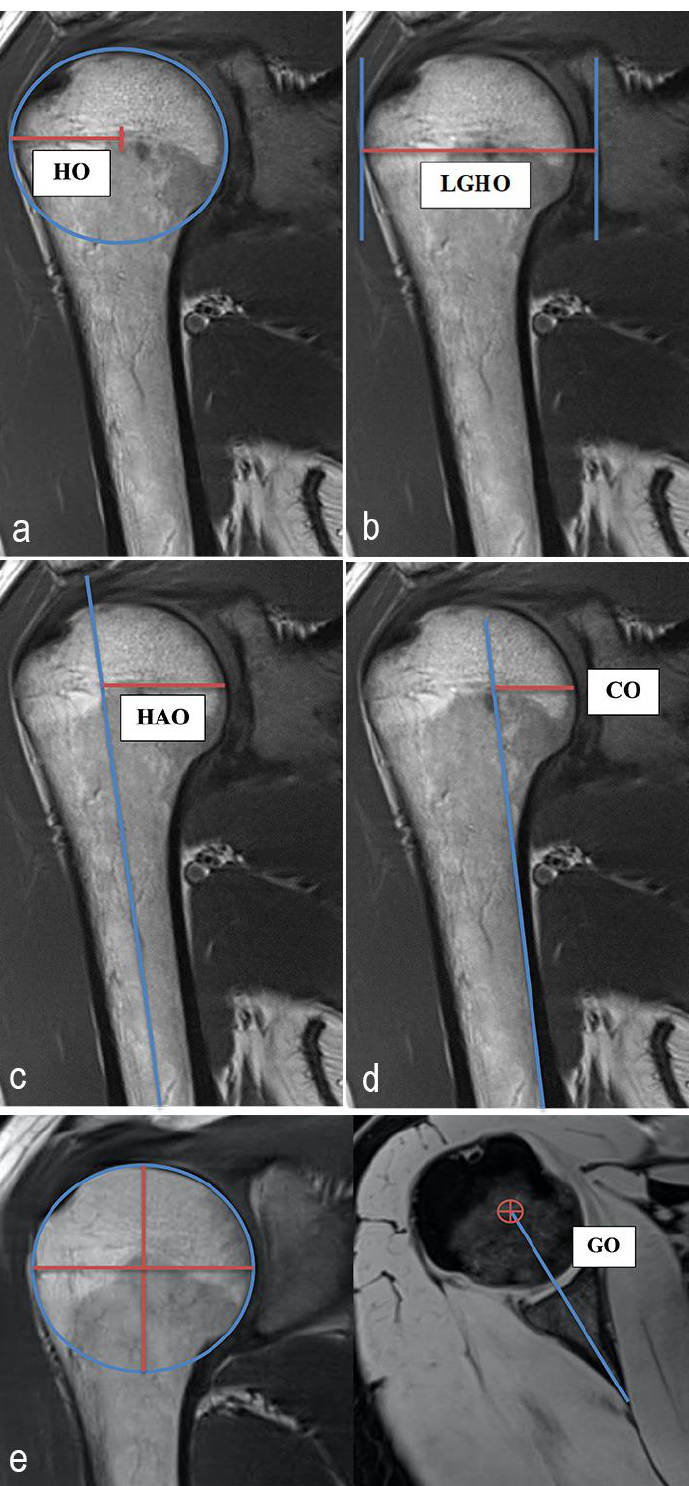
Figure 1. Exemplary depiction of the measurements of the humeral offset (HO, a ), lateral glenoidal humeral offset (LGHO, b ), humeral shaft axis offset (HAO, c ), cortical offset (CO, d ) and